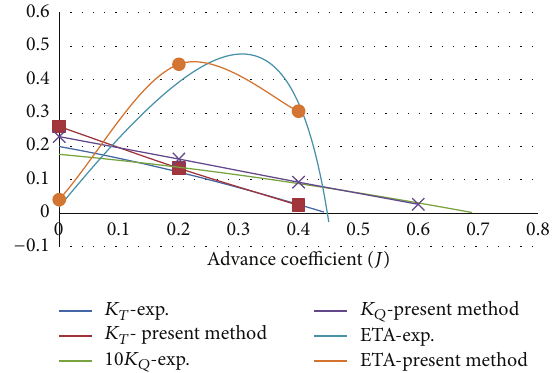
Figure 4: Hydrodynamic coefficient of the investigated propeller with 𝑃/𝐷 = 0.5 .